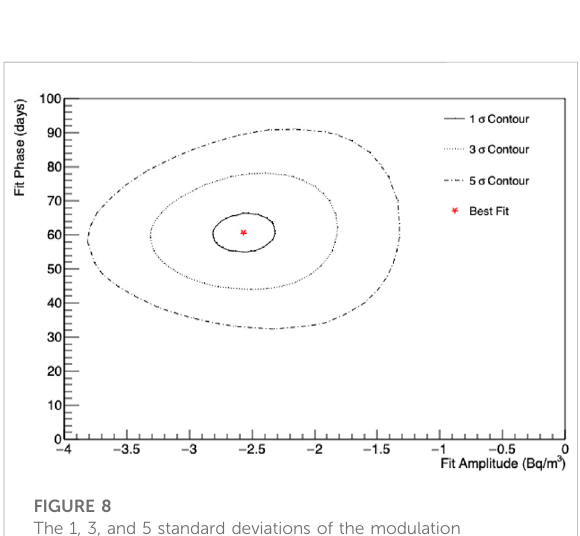
FIGURE 8 The 1, 3, and 5 standard deviations of the modulation amplitude-phase χ 2 scan. The best fi t position is indicated with a red star marker while three contour lines are with different styles. Zero amplitudes indicate no modulation. Days in the y-axis are counted from 1st July in the case of the negative